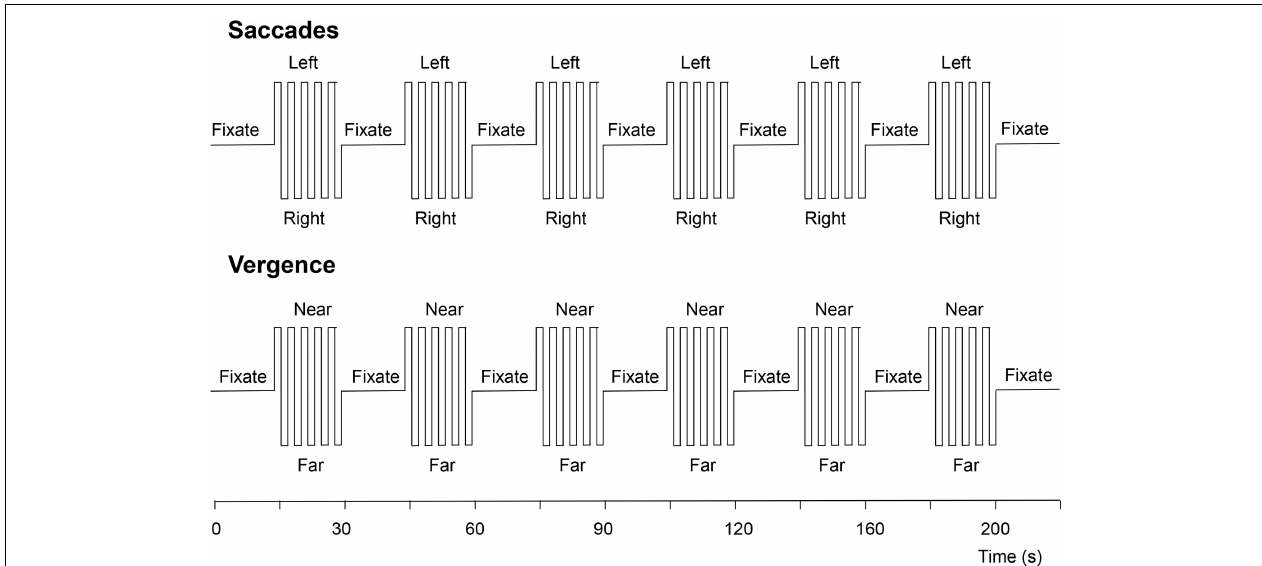
FIGURE 5 | Functional magnetic resonance imaging protocols for the visually driven saccadic and vergence eye movements . See text for details.